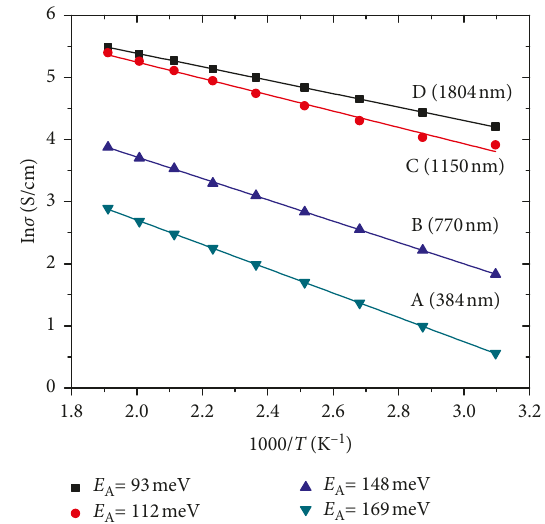
Figure 4: Plot of ln σ versus 1000/ T for Sb